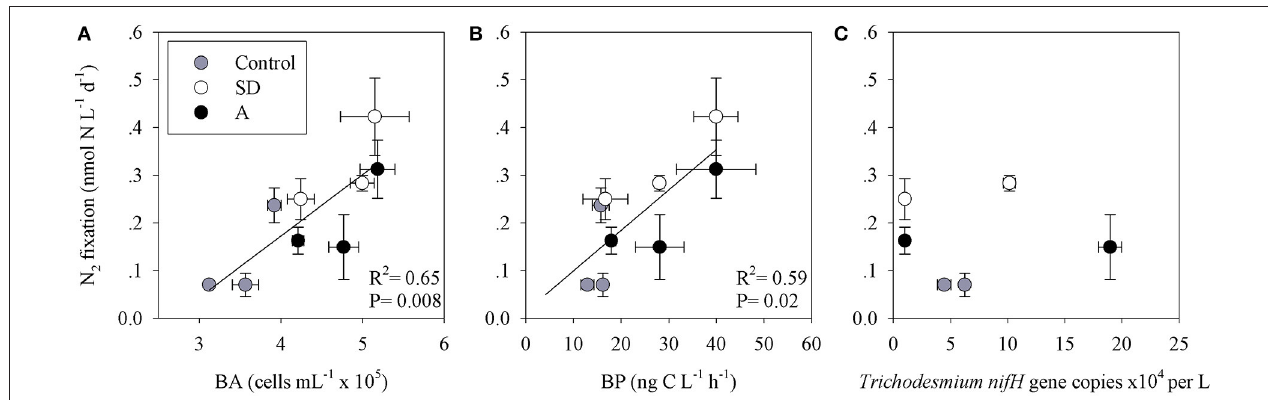
FIGURE 5 | The relationship between N 2 fixation and (A) bacterial abundance; BA, (B) bacterial production; BP, and (C) Trichodesmium nifH copies, in the first 144h following the Saharan dust (SD) and mixed aerosol (A) enrichments.